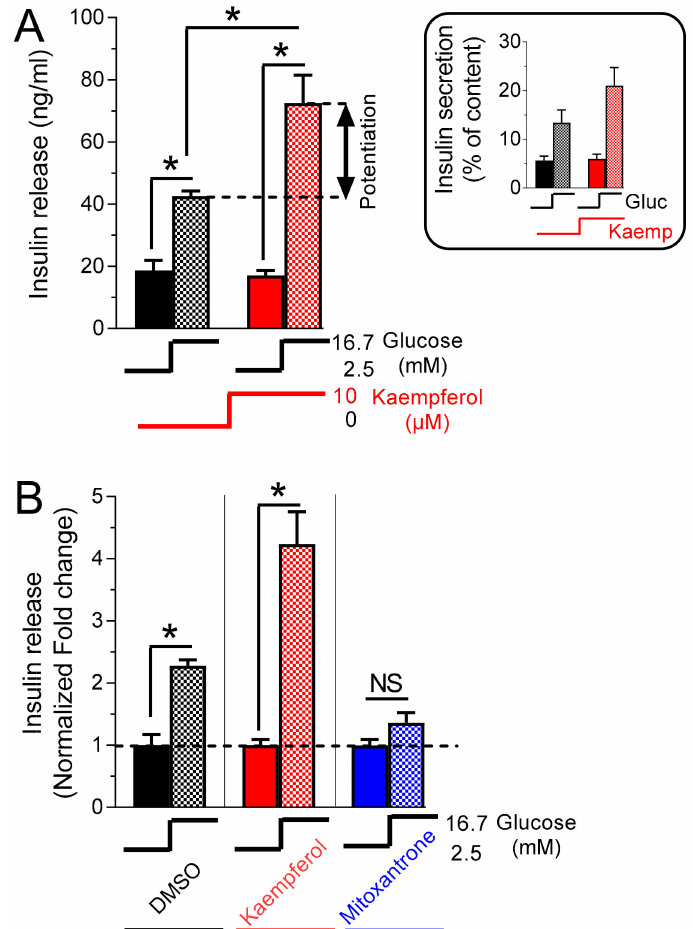
Figure 3. Kaempferol potentiates glucose-stimulated insulin secretion, whereas mitoxantrone inhibits glucose-stimulated hormone exocytosis. Static insulin secretion measurements. ( A ) Insulin